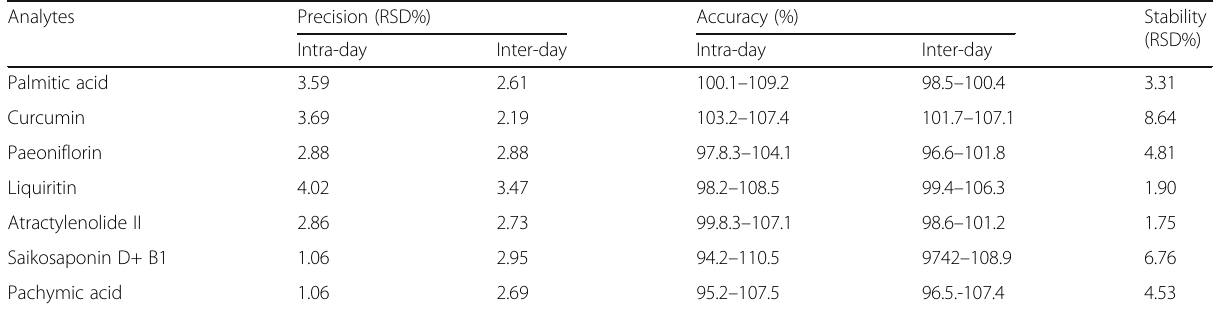
Table 4 Precision, accuracy and stability in XYS sample